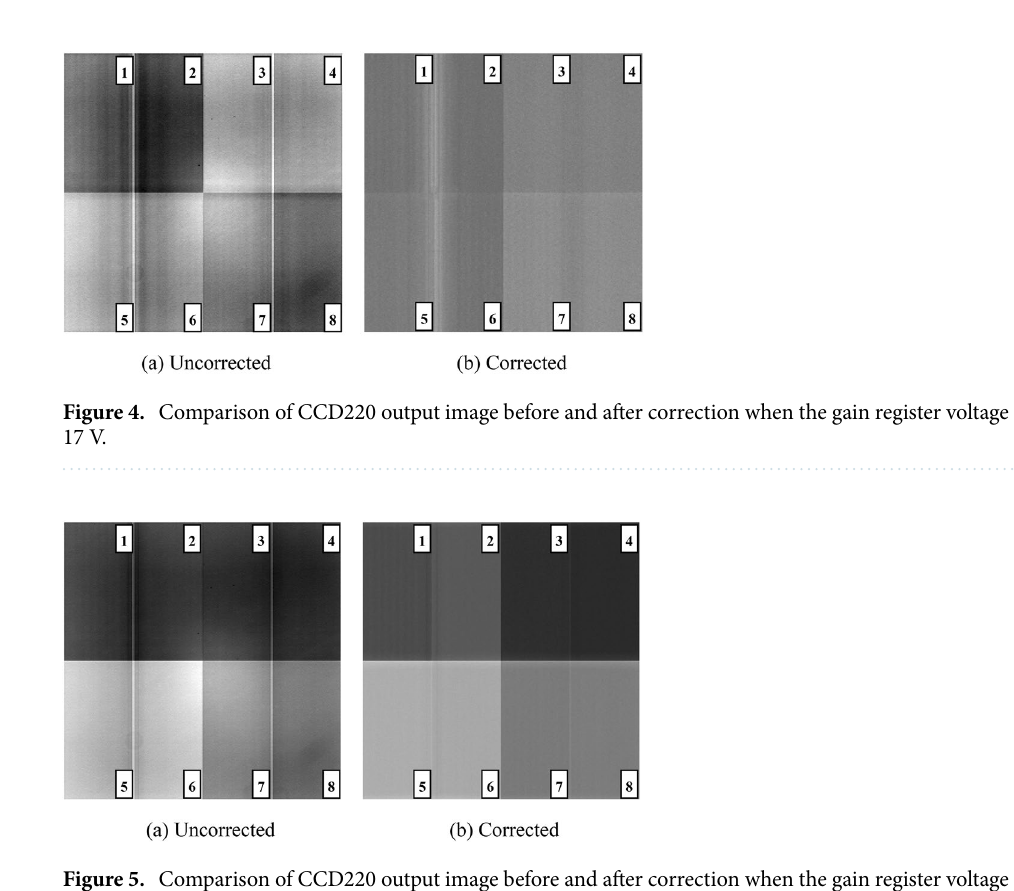
Figure 5. Comparison of CCD220 output image before and after correction when the gain register voltage is 34